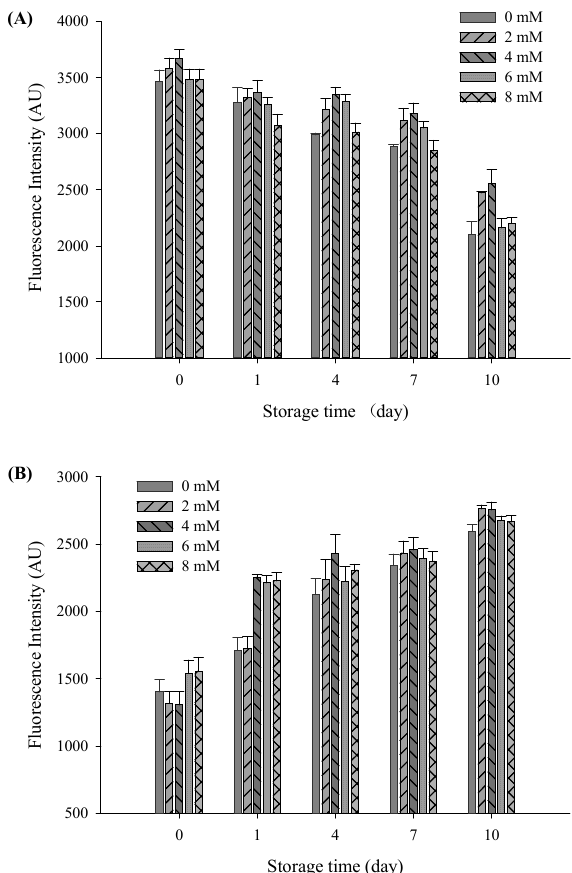
Figure 7. Tryptophan fluorescence spectra ( A ) and FP fluorescence spectra ( B ) of the filled hydrogel system containing different CaCl 2 levels at different storage times at 37 °C.